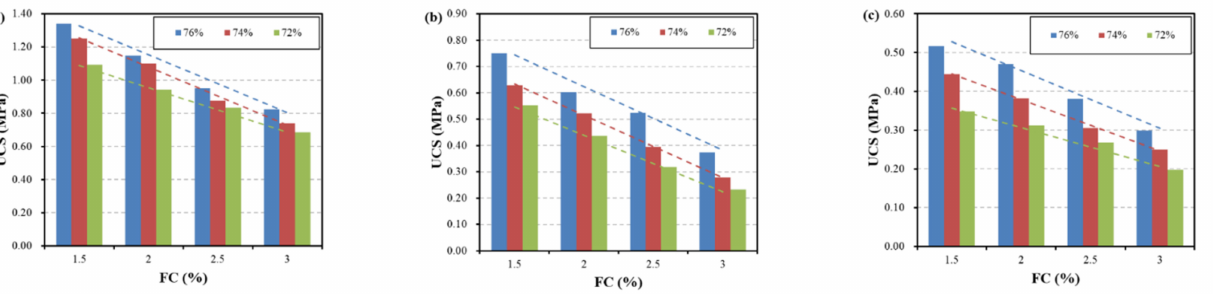
Figure 11. Relationships between FC and the UCS of FCPB. ( a ) CTR = 1:4, T = 28 d; ( b ) CTR = 1:6, T = 28 d; ( c ) CTR = 1:8, T = 28